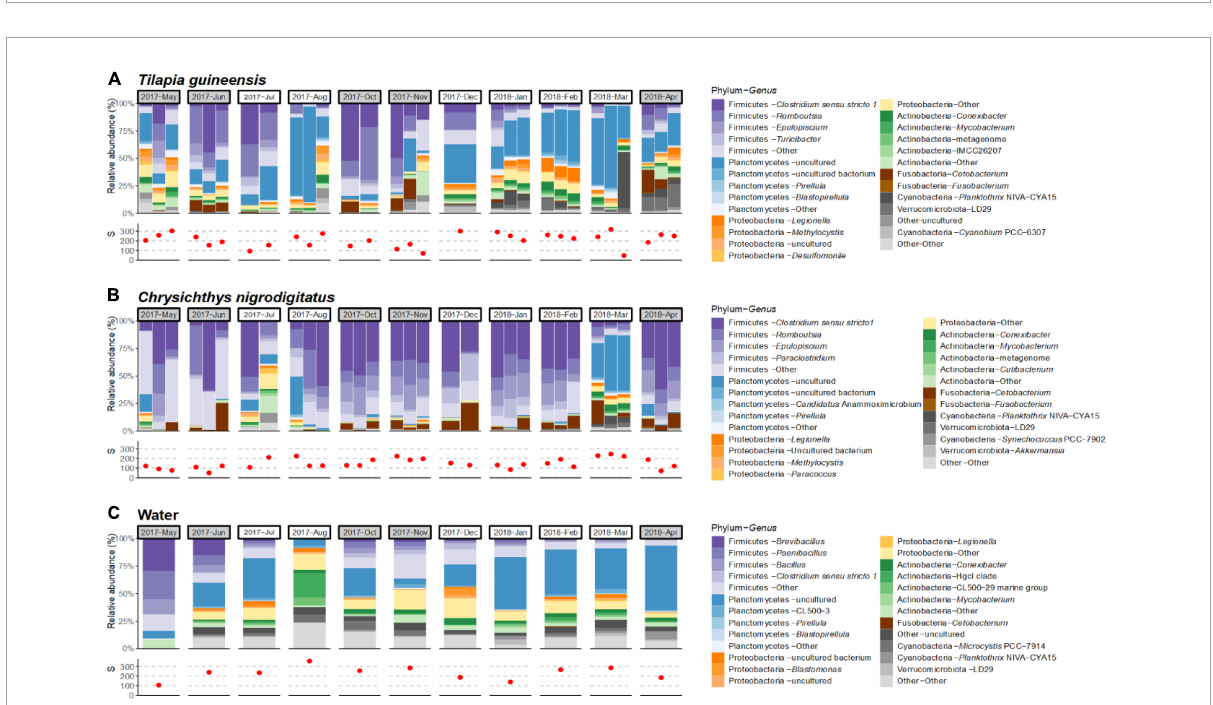
FIGURE3 Temporal profiles over a year of community compositions for each individual sample at the genus level (only the most abundant genera within the overall dataset are displayed) and species richness (S), in Tilapia guineensis (A) , Chrysichthys nigrodigitatus (B) , and water samples (C) . Months corresponding to rainy seasons are colored in gray. Red dots represent observed amplicon sequence variant (ASV) richness. Affiliation “Other” corresponds to the group of low-abundance